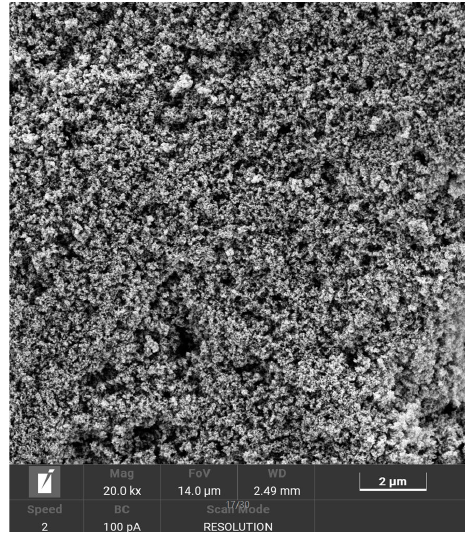
Figure 2. SEM image of SUPL.